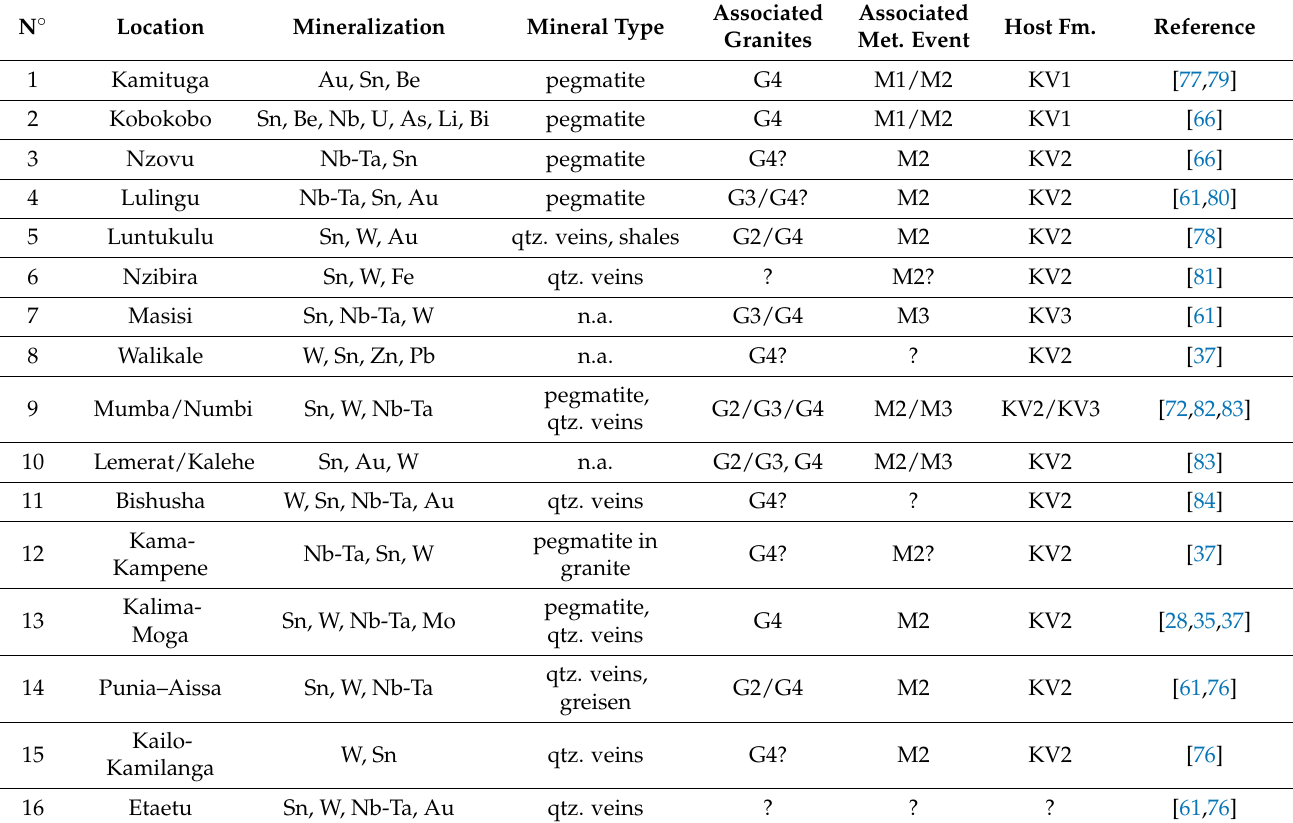
Table 2. The main mineral occurrences in the Kivu Belt. Associated granites, metamorphism, host rocks, and bibliographic references are